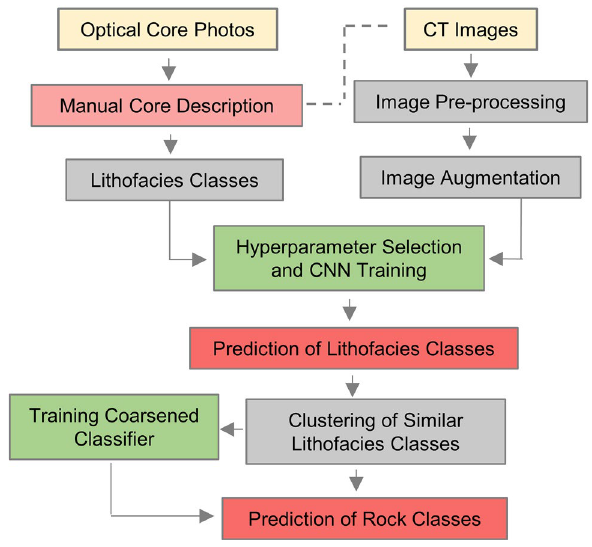
Fig. 1 Proposed workflow for lithofacies